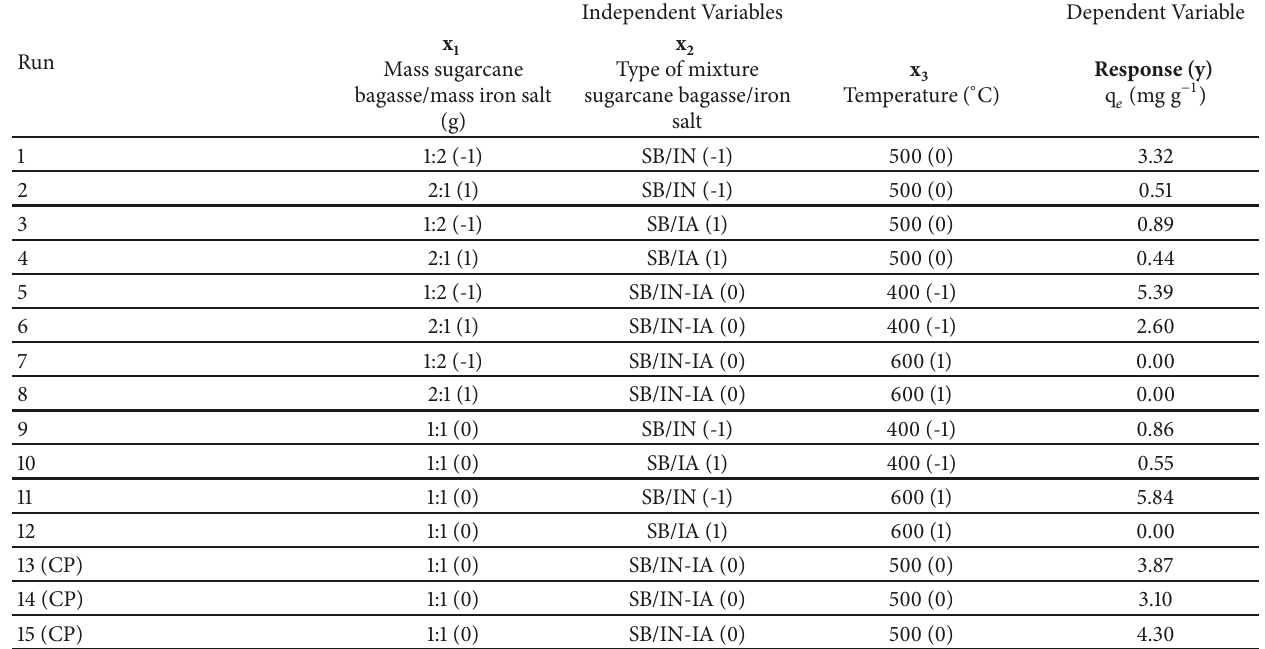
) of each test performed. e